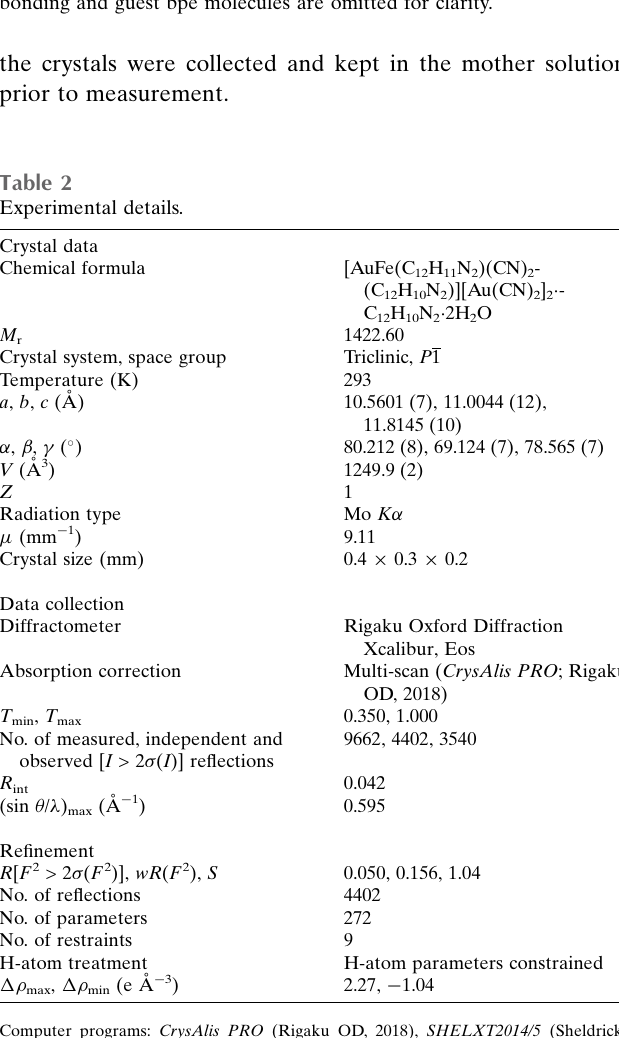
Figure 3 A view along the a axis of the crystal packing showing the network of hydrogen bonds as black dashed lines. H atoms not involved in hydrogen bonding and guest bpe molecules are omitted for clarity.